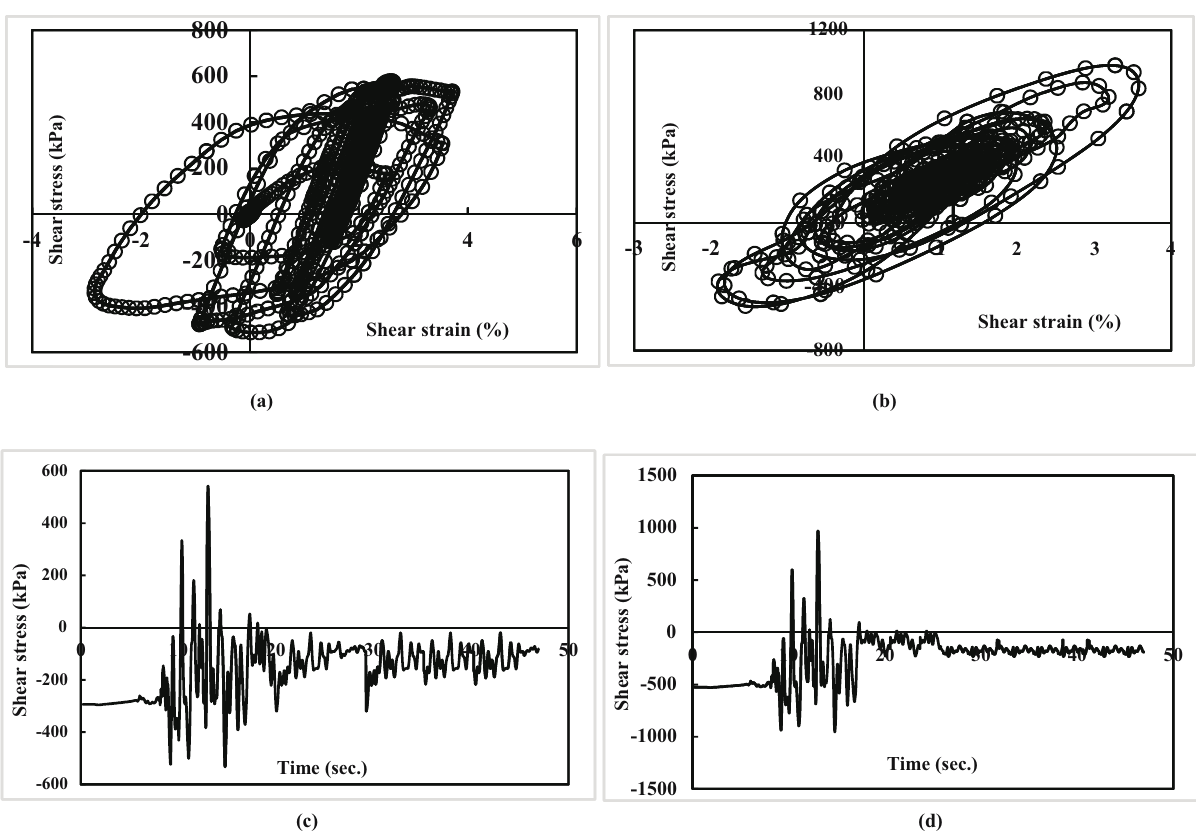
Figure 4: The shear stress – strain relationship with the corresponding shear stress time history: ( a ) closed - ended pipe pile, ( b ) open - ended pipe pile, ( c ) closed - ended pipe pile, and ( d ) open - ended pipe